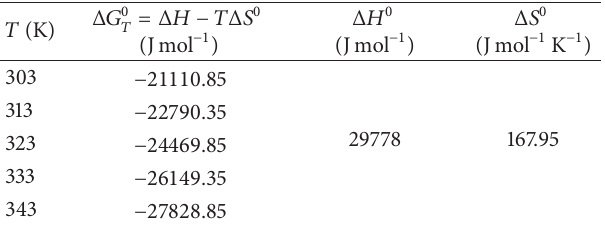
Table 3: Thermodynamic parameters for the adsorption of AB dye on